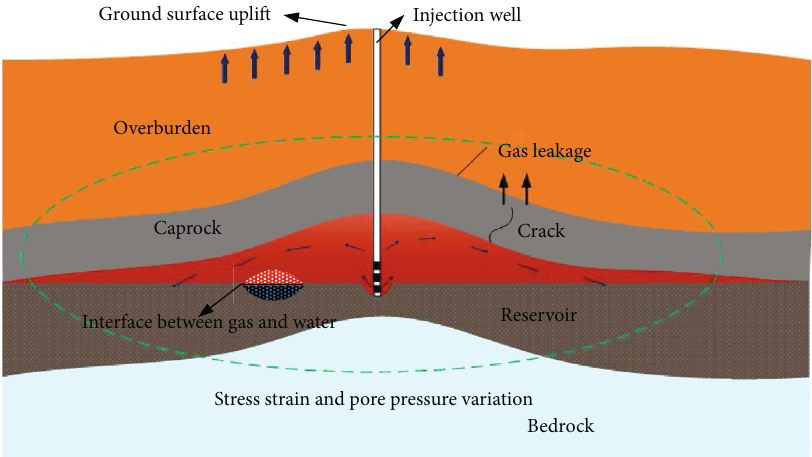
Figure 4: Schematic diagram of geomechanical problems of gas storage.